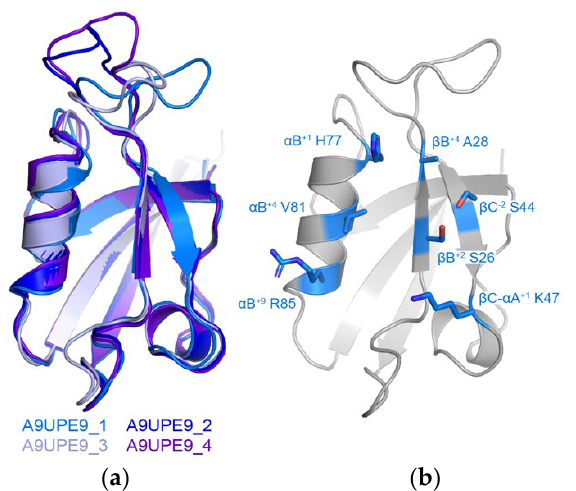
Figure 3. Model of A9UPE9 PDZ structure. The four conformations from Robetta are in cartoon representation and colored as labeled in ( a ). ( b ) Identification of peptide-binding cleft residues in A9UPE9 conformation 1 (A9UPE9_1). Residues used for analysis are shown as side chain sticks, colored marine by heteroatom (N = blue, O = red) and